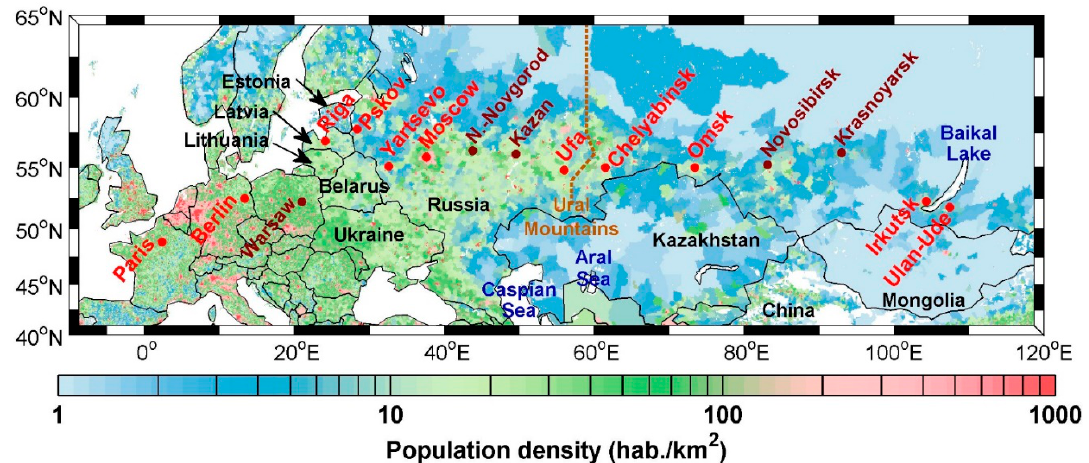
Figure 1. Map of the campaign itinerary showing the location of the 11 cities included in this study (red dots) plus the other large cities crossed during the transect (brown dots). The map background shows the 2015 population density [44].